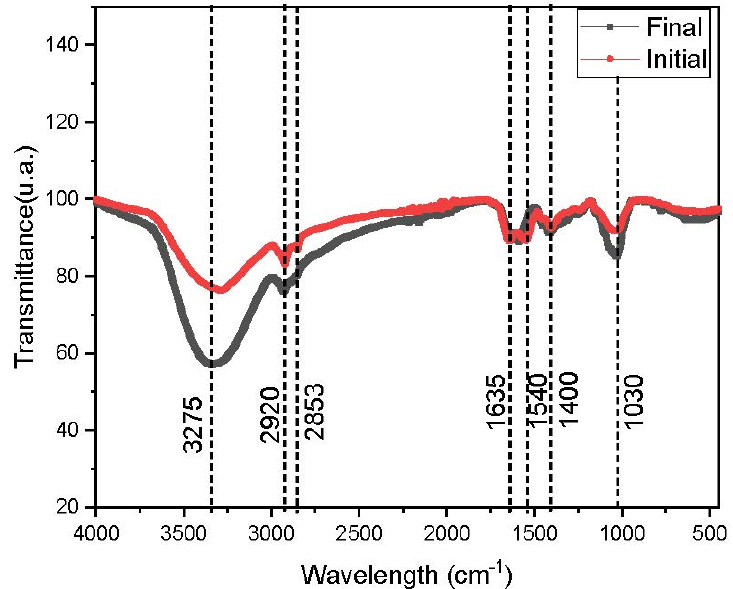
Figure 5. Initial and final transmittance spectrum of GB waste.